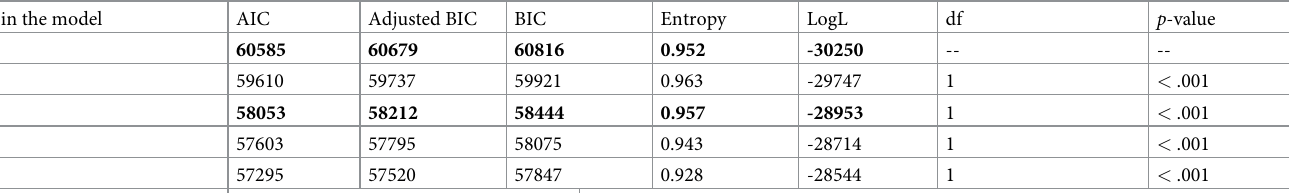
Table 2. Latent profile analysis based on COVID-19 behaviours and attitudes.